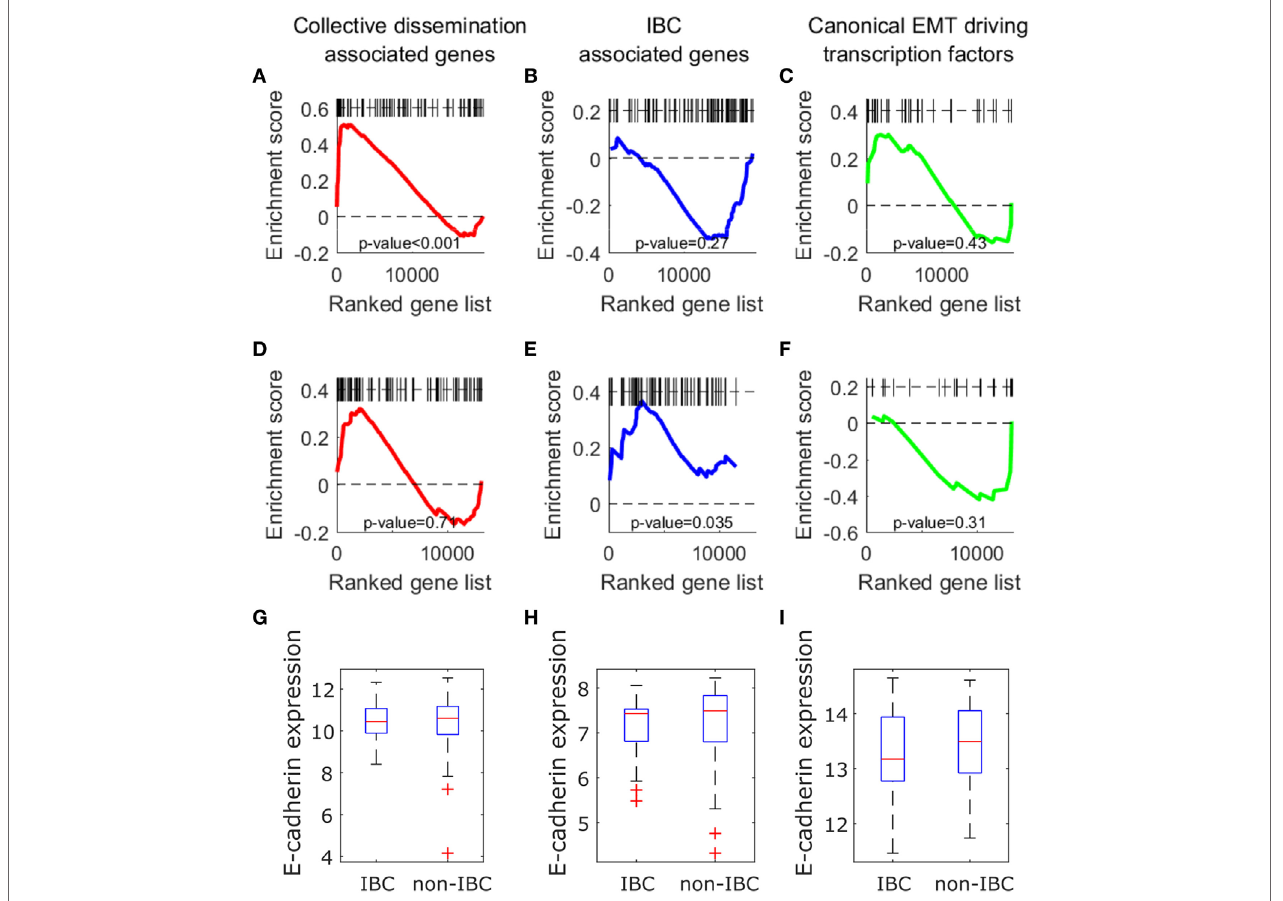
FigUre 9 | (a–F) Gene set enrichment analysis using collective dissemination-associated genes (a,D) , inflammatory breast cancer (IBC)-associated genes (B–e) , and canonical epithelial-to-mesenchymal transition driving transcription factors (c–F) on: (a–c) gene expression data for epithelial and mesenchymal cell lines from the study by Grosse-Wilde et al. (39) and on (D–F) gene expression data for tumor samples from IBC and non-IBC breast cancer patients from the study by Iwamoto et al. (45). In (a–c) , genes are ordered from left to right in decreasing order of correlation of expression with the epithelial phenotype. In (D–F) , genes are ordered from left to right in decreasing order of correlation of expression with the IBC phenotype. Black bars along the top of each plot indicate the positions of hits to the gene set along the ordered list of genes. Nominal p -values of enrichment are indicated at the bottom of each plot. (g–i) Mean expression of CDH1 (E-cadherin) gene in tumor samples from IBC and non-IBC breast cancer patients in studies by (g) Iwamoto et al. (45), (h) Boersma et al. (46), and (i) Woodward et al.